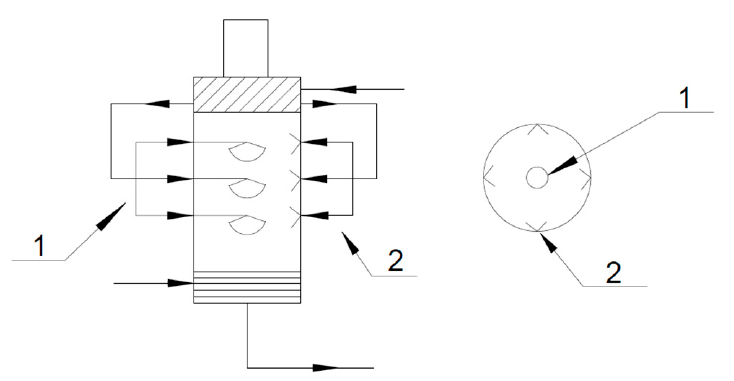
Figure 10. Types and atomization effect of nozzles. ( A )—Spiral nozzle. ( B )—Direct nozzle. The nozzles were installed in three layers inside the spray tower. The spiral nozzles were installed in the center of the spray tower at the upper, middle, and lower parts of it. In addition, four direct injection nozzles were installed on the wall of the tower, as shown in Figure 11.